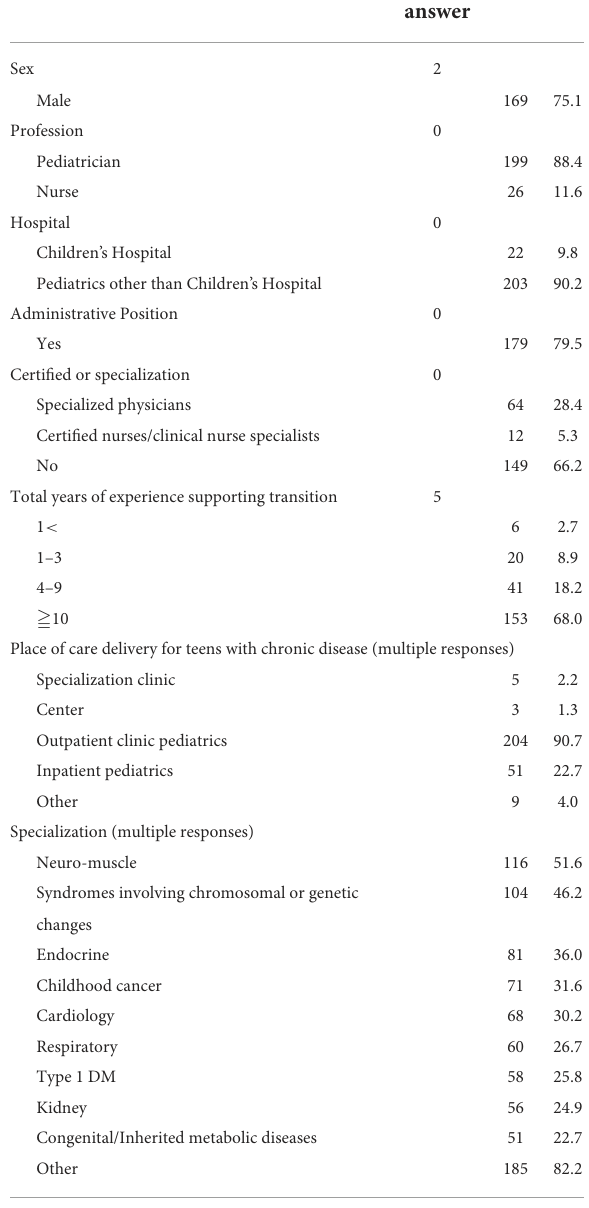
TABLE 1 Participants background ( n =